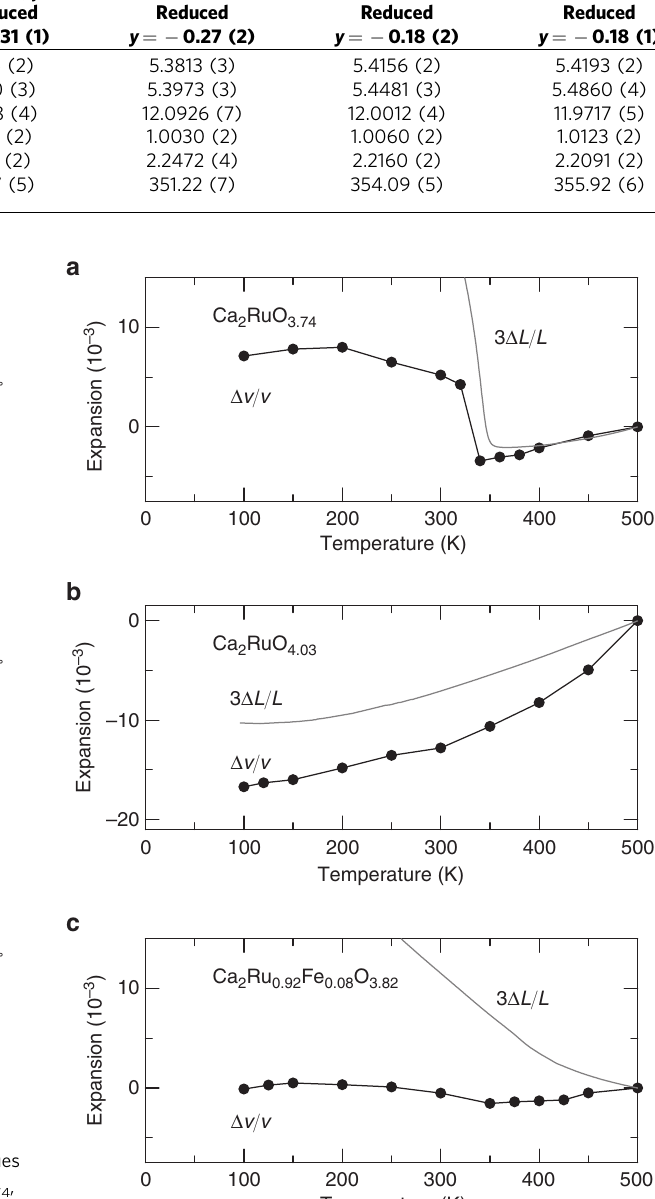
Figure 4 | Volumetric thermal expansion of Ca 2 Ru 1 (cid:2) x M x O 4 þ y . ( a ) Ca 2 RuO 3.74 , ( b ) Ca 2 RuO 4.03 and ( c ) Ca 2 Ru 0.92 Fe 0.08 O 3.82 . Results estimated from crystallographic ( D v / v ) measurements are compared with the dilatometry (3 D L / L ) results. Reference temperature: 500K. The discrepancy is conspicuous when the dilatometric negative thermal expansion becomes